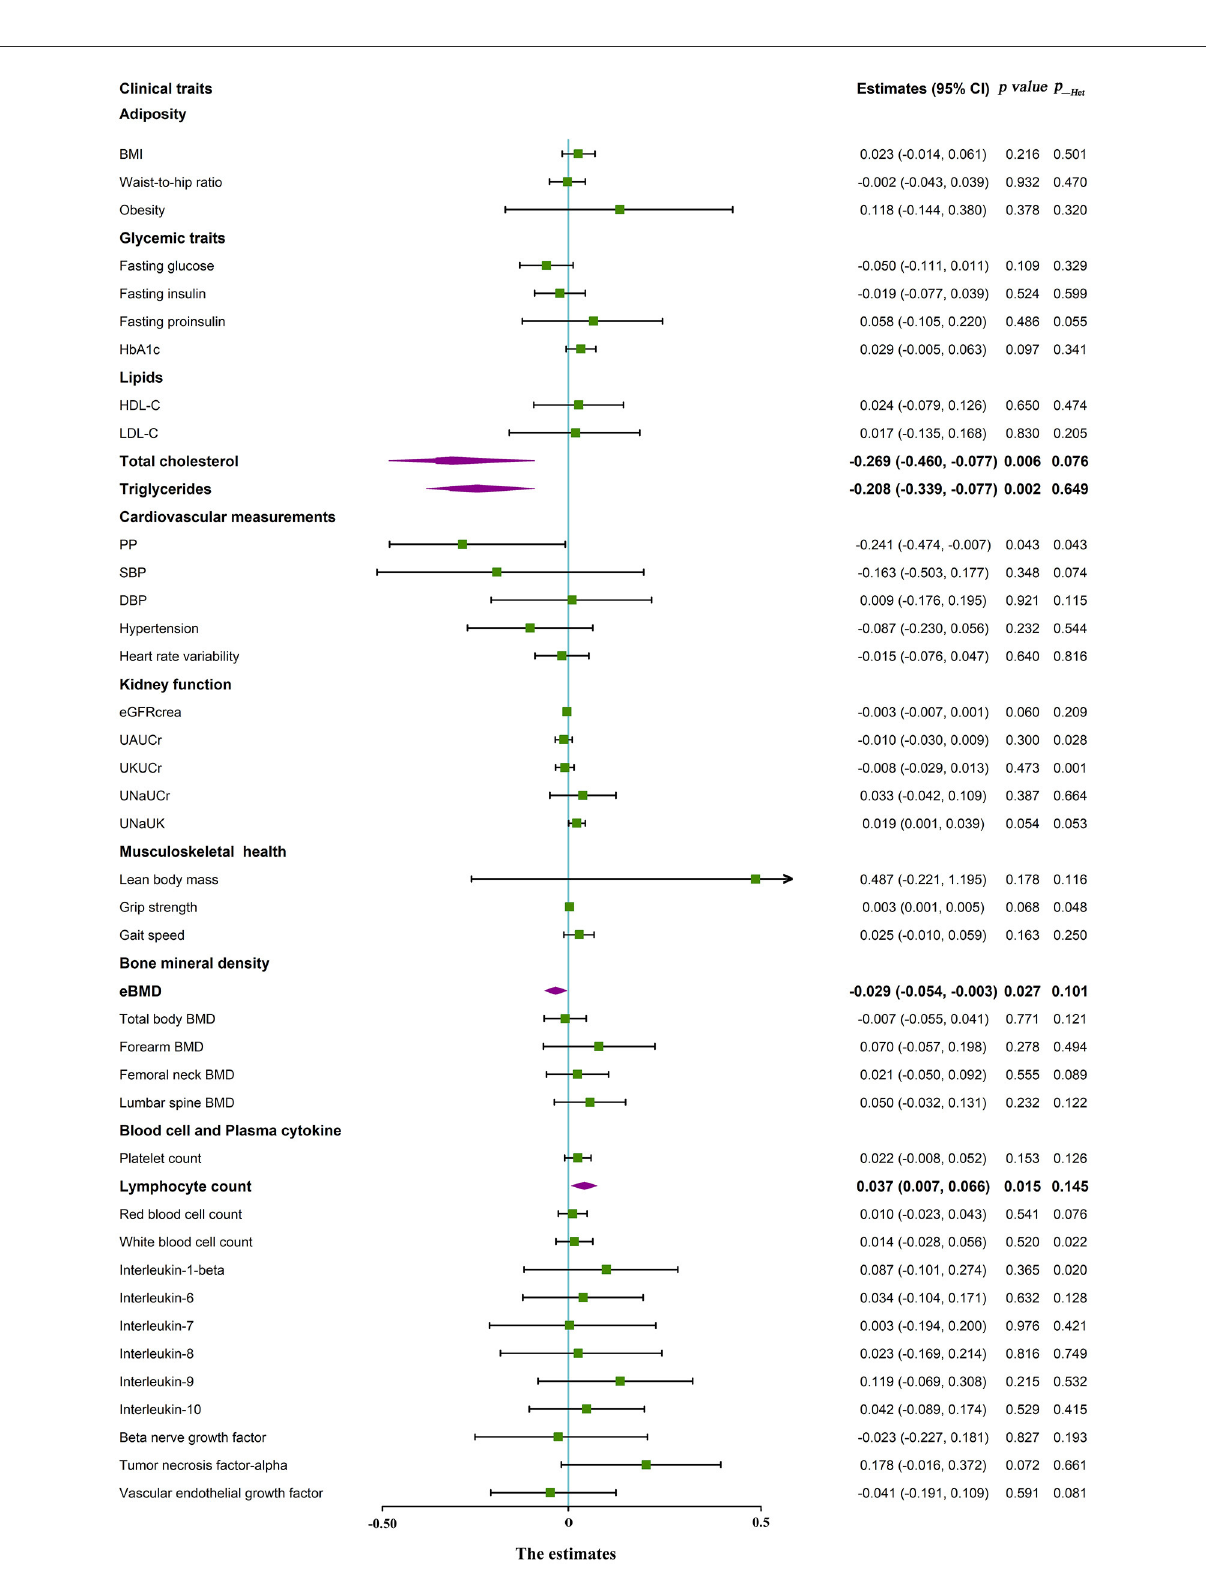
FIGURE2 Forest plot about the association between circulating 25(OH)D and clinical traits in Mendelian randomization analysis. BMI, body mass index; eBMD, estimated bone mineral density; HDL, high density lipoprotein cholesterol; LDL, low density lipoprotein cholesterol; PP, pulse pressure; SBP, systolic blood pressure; DBP, diastolic blood pressure; eGFR, estimated glomerular filtration rate; UAUCr, urinary albumin to creatinine ratio; UKUCr, urinary potassium to creatinine ratio; UNaUCr, urinary sodium to creatinine ratio; UNaUK, urinary sodium to potassium ratio; p _ Het, heterogeneity